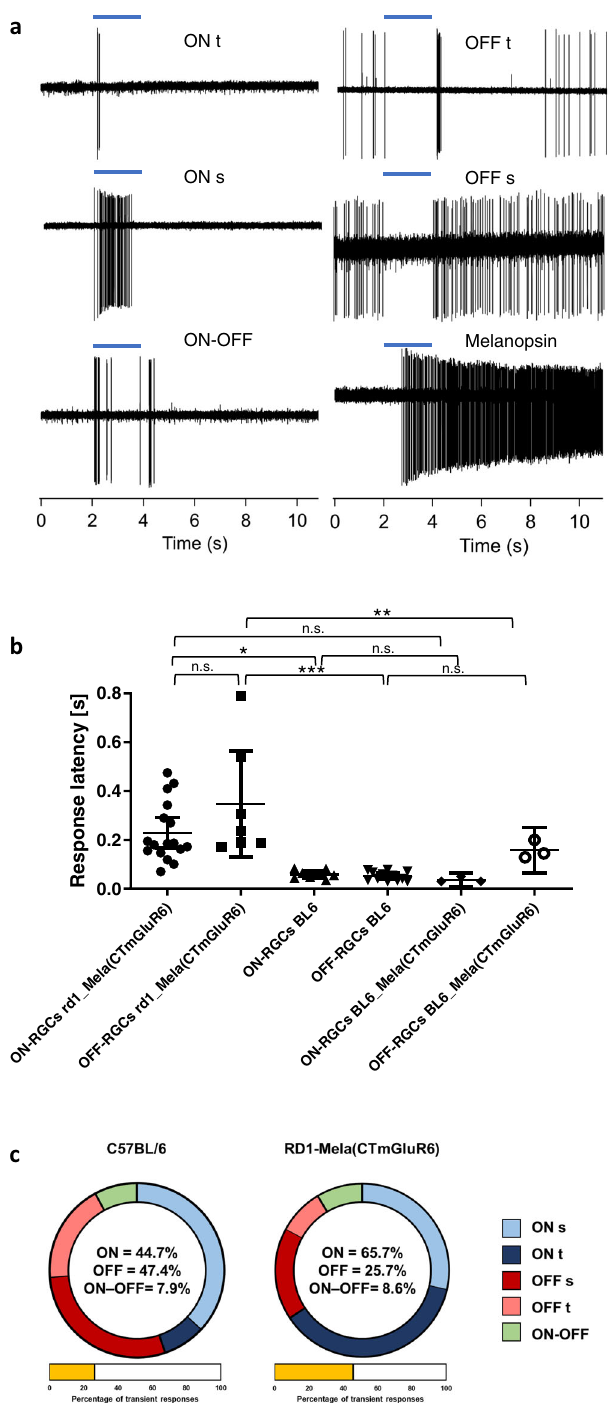
Fig. 4 Mela(CTmGluR6) restores diverse receptive- fi eld types in the RGC population of the degenerated rd1 retina. a Extracellular recordings from RGCs in the Mela(CTmGluR6)-treated rd1 retina during light stimulation reveal restoring a diversity of RGC light-responses: transient ON (ON-T), transient OFF (OFF-T), sustained ON (ON-S), sustained OFF (OFF-S), ON – OFF as well as melanopsin responses from ipRGCs. b The response onset of ON and OFF RGCs in treated rd1 retinas had a relatively wide scatter compared to the WT retina [n(ON-RGCs rd1_Mela(CTmGluR6)) = 17, n (OFF-RGCs rd1_Mela(CTmGluR6)) = 7, n (ON-RGCs BL6) = 8, n (OFF- RGCs BL6) = 12, n (ON-RGCs BL6_Mela(CTmGLuR6)) = 4, n (OFF-RGCs BL6_Mela(CTmGluR6)) = 3]. Data shown as means ± SD, individual data points depicted as black symbols. c Charts showing the relative fraction of receptive- fi eld types (excluding melanopsin) recorded in the WT and the Mela(CTmGluR6)-treated rd1 retina. Compared to the WT retina, we observed a relative shift from OFF to ON response types and from sustained to transient responses in the treated